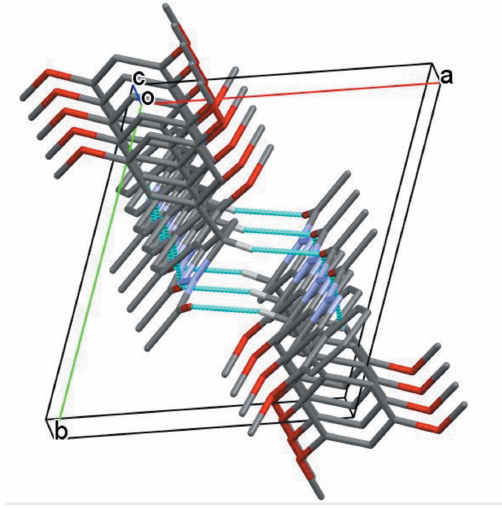
Figure 3 Part of the crystal structure with hydrogen bonds shown as dashed lines. For clarity, only those H atoms involved in hydrogen bonding are shown.